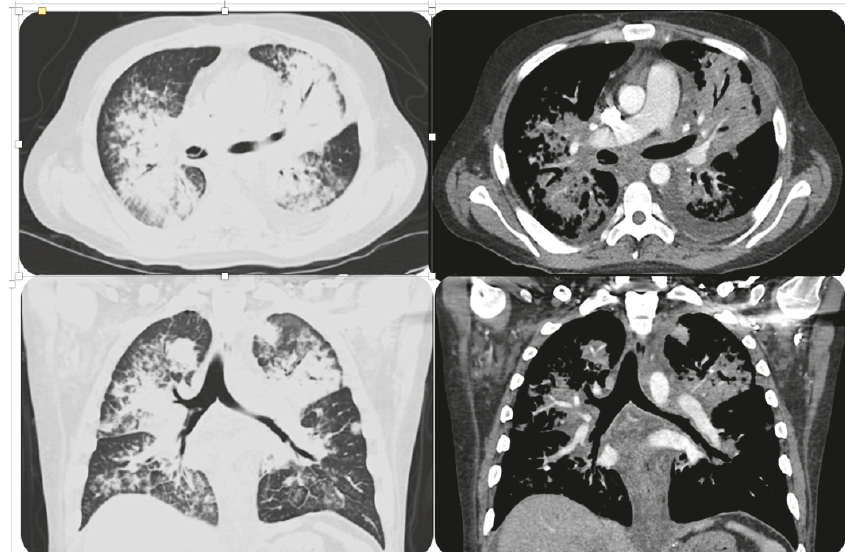
Figure 2: Computed tomography of the chest showed diffuse peribronchovascular consolidative opacities with surrounding ground glass opacities, interlobular septal thickening, and infiltrative soft tissue densities throughout the mediastinum. There is also a linear filling defect in the bronchus intermedius.